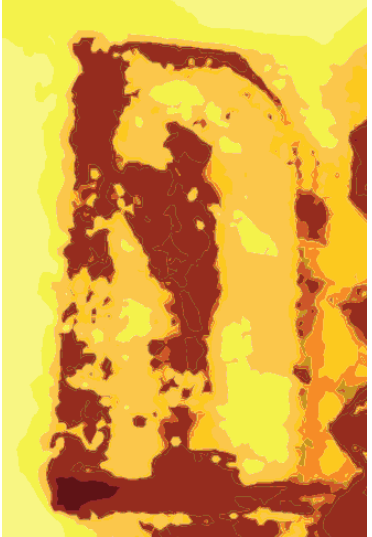
Fig. 7. A digital model was obtained from regular TIN